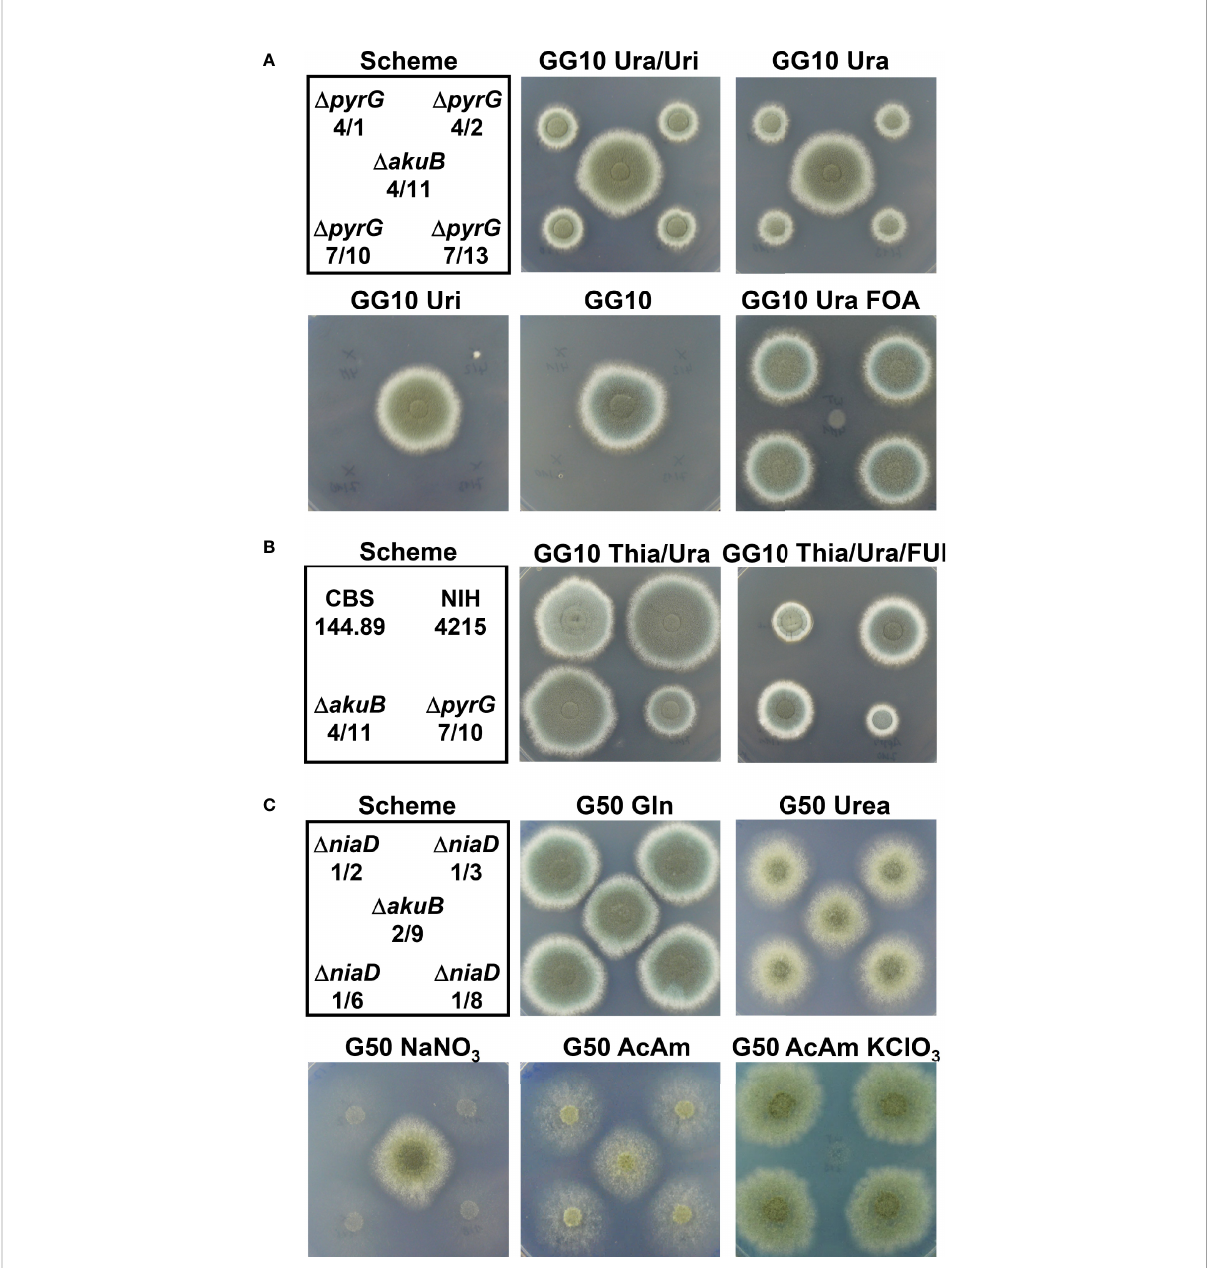
FIGURE 6 Growth analysis of D pyrG and D niaD mutants derived from the bioluminescent D akuB strains. (A) Growth analysis of D pyrG strains in comparison to the parental D akuB 4/11 strain. A spotting scheme for 10 4 conidia from each strain is shown on the left. Glucose minimal medium with 10 mM glutamine as nitrogen source (GG10) served as basic growth medium. Media were additionally supplemented with either a combination of uracil and uridine (Ura/Uri, 10 mM each) or uracil (Ura, 10 mM) or uridine (Uri, 10 mM) alone. In addition, resistance against 4 mg/ml FOA in the presence of uracil was tested. All pictures were taken after 60 h of incubation at 37°C except for the FOA-containing plate that was photographed after 78 h. Uridine does not complement the D pyrG phenotype and growth in the presence or uracil is delayed. All pyrG mutants show the expected resistance against FOA. (B) Test of the A. fumigatus wild-type strain CBS144.89, the NIH4215 strain and the derived D akuB 4/ 11 and the D pyrG 7/10 strain against 5- fl uorouridine (FUI). GG10 medium supplemented with thiamine and uracil served as control and was compared at 64 h against a medium additionally supplemented with 2 mM FUI. Although growth of all strains is affected by FUI, strain NIH4215 and derivatives show normal colony morphology and appear less affected. (C) Growth analysis of selected D niaD strains in comparison to the parental D akuB 2/9 strain. A spotting scheme for 10 4 conidia from each strain is shown on the left. Glucose minimal medium (G50) served as basis and was supplemented with different nitrogen sources. Gln, 10 mM glutamine; Urea, 10 mM urea; NaNO 3 , 70 mM sodium nitrate; AcAm, 20 mM acetamide; AcAm KClO 3 , 20 mM acetamide + 120 mM potassium chlorate. All pictures were taken after 60 h of incubation at 37°C except for the chlorate – containing plate that was photographed after 120 h. All niaD mutants show the expected inability to utilise nitrate, but show an increased chlorate